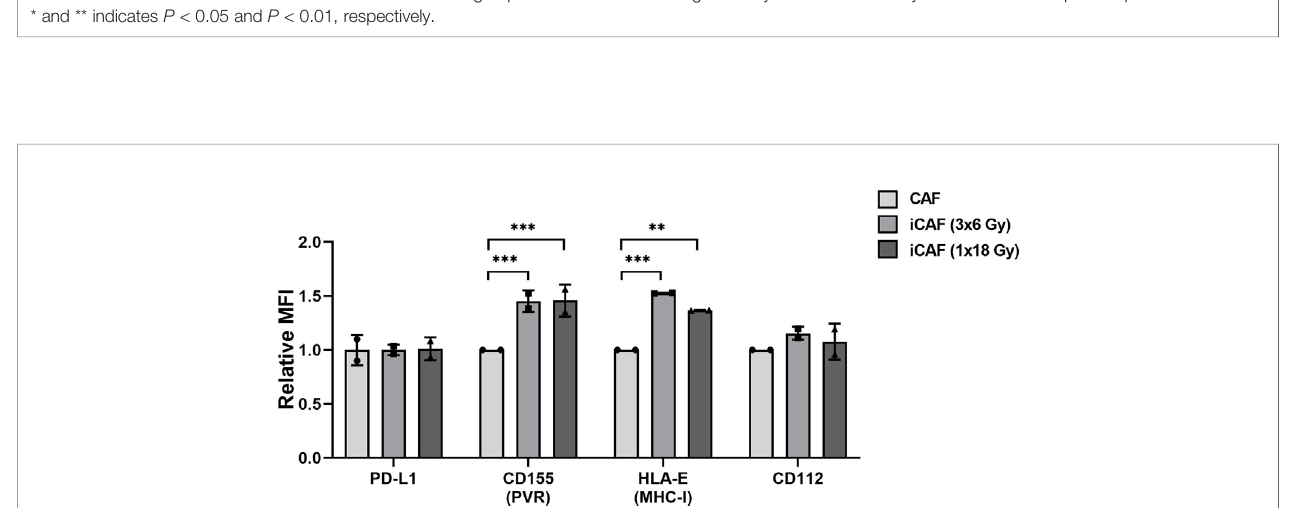
FIGURE 8 | Effects of radiation on cancer-associated fi broblast (CAF) surface expression of checkpoint molecules. Surface expression of checkpoint ligands PD-L1, CD155, CD112, and HLA-E (MHC-I) were analyzed by fl ow cytometry on control and irradiated CAFs (iCAFs). Results are expressed as fold non-irradiated CAF median fl uorescence intensity (MFI). Bars represent mean (± SD) values from two different CAF donors. Statistical P -values between control CAFs and irradiated CAF-groups were determined using two-way ANOVA with Dunnett correction for multiple comparisons. ** P < 0.01 and *** P <